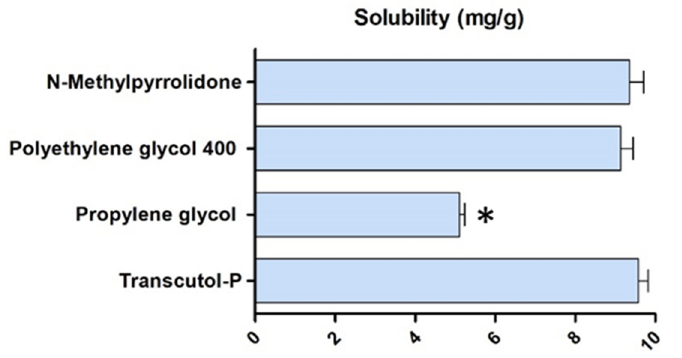
Figure 2. Solubility of DPZ in different cosolvents. * Statistically significant differences with N-methylpyrroline, polyethylene glycol 400, and Transcutol-P; statistical significancy set at p < 0.05. The composition of the three DPZ-loaded gels obtained in this study are detailed in Table 1. For DPZ-CGel preparation, chitosan (1%) was dissolved in 0.1 M aqueous acetic acid solution (20%) and then water (59%) was added to this mix. DPZ (6.25 mg/mL) was solubilized in Transcutol ® P (20%) and then incorporated to the chitosan solution. For thermoreversible formulations DPZ-PGel 1 and DPZ-PGel 2 , Pluronic F-127 (18%) was dissolved in cold purified water and then DPZ (6.25 mg/mL) previously solubilized in Transcutol ® P (20%) or N-Methylpyrrolidone (5%) was added to the polymer solution, respec- tively (Table 1). Table 1. Composition formula of donepezil-loaded gels, expressed as percentage. Ingredients (% w / w )